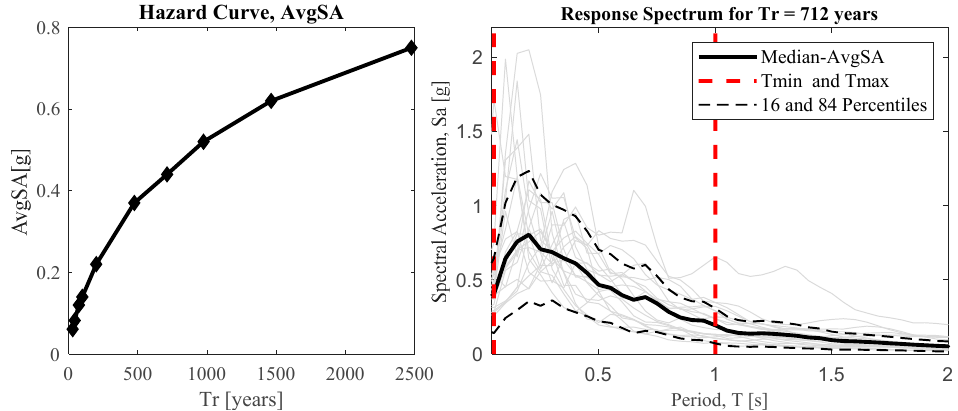
Figure 9. Hazard curve for the case study location and response acceleration spectrum for a return period of 712 years.